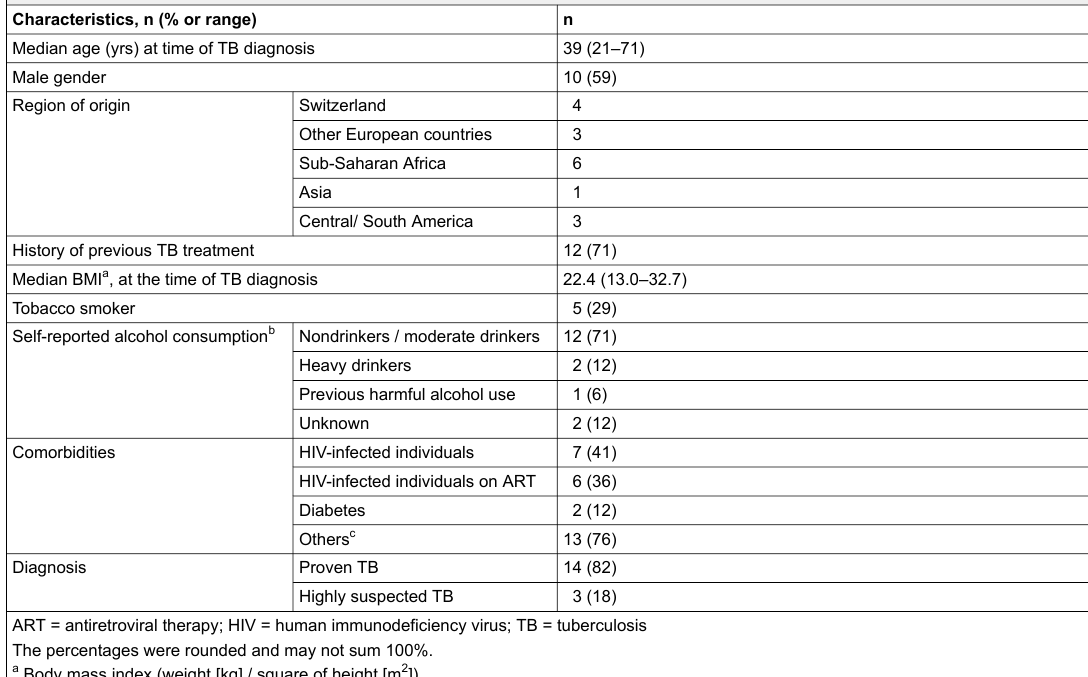
Table 1: Baseline characteristics of the 17 enrolled patients with proven or highly suspected tuberculosis.